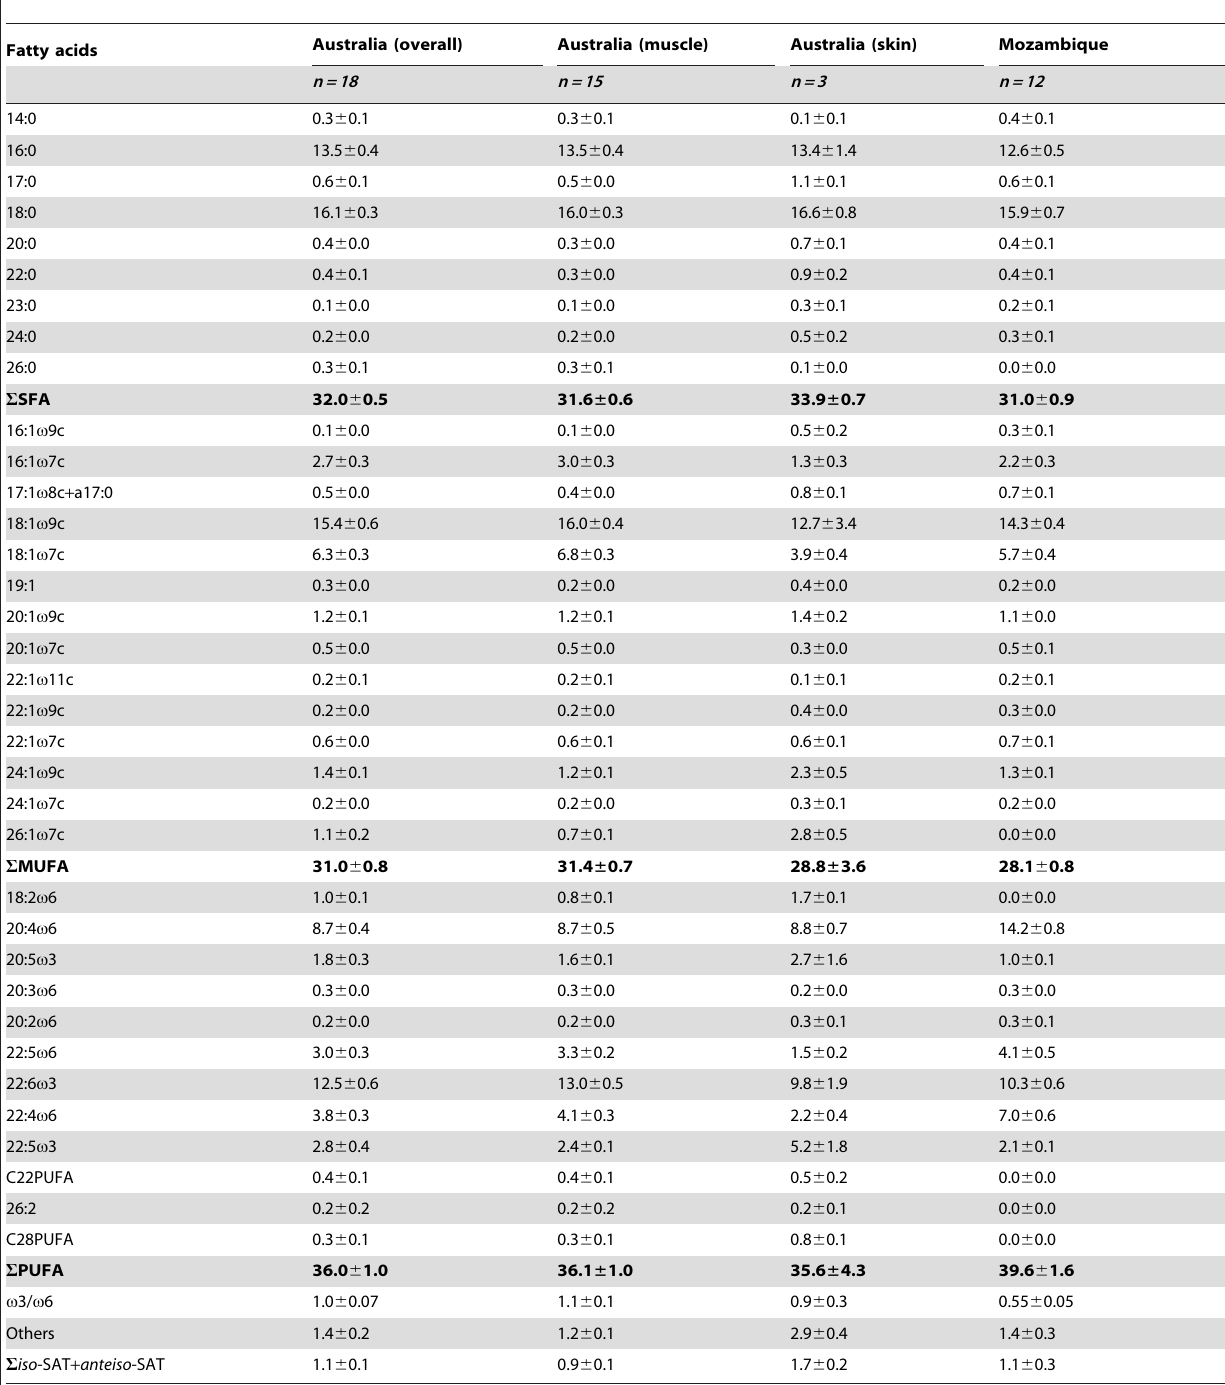
Table 2. Fatty acid composition (mean 6 standard error %of total FA) for tissue biopsies of the reef manta ray Manta alfredi collected off eastern Australia and Mozambique.